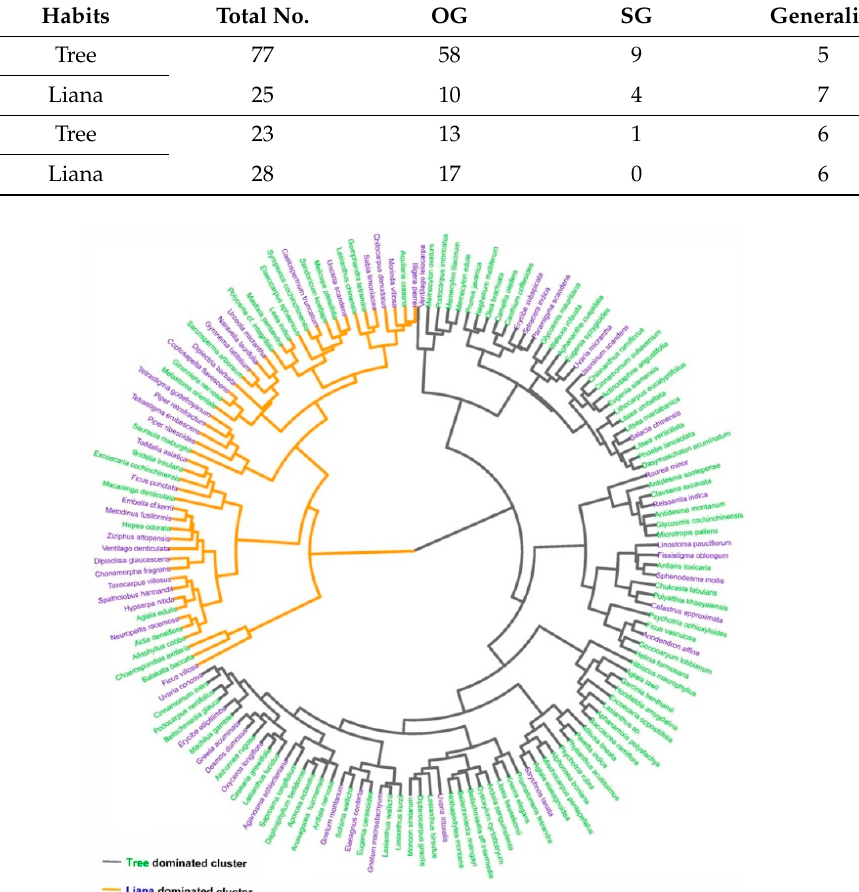
Figure 2. Clustering of species by all functional traits. Colors of branches indicate clusters: tree- dominated cluster in dark grey and liana-dominated cluster in brown. Species color indicates tree or liana: trees in green and lianas in blue.